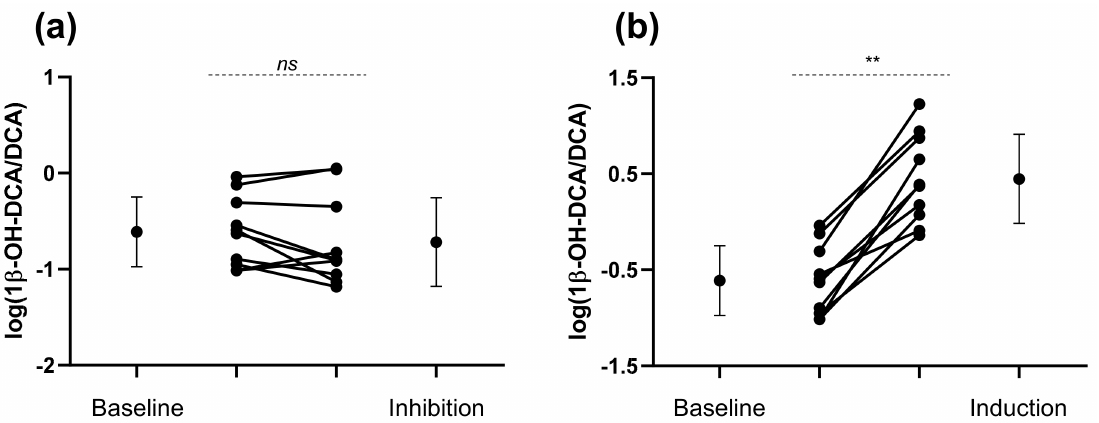
Figure 3. Eight-hour 1 β -hydroxy-deoxycholic acid/deoxycholic acid individual urinary metabolic ratios at baseline and after ( a ) the inhibition by voriconazole and fluvoxamine, and ( b ) induction by rifampicin. Error bars represent the standard deviations of log-transformed 1 β -hydroxy-deoxycholic acid (1 β -OH-DCA/DCA) and mean values are displayed with a circle. 1 β -OH-DCA/DCA, 1 β -hydroxy-deoxycholic acid/deoxycholic acid. ** p <